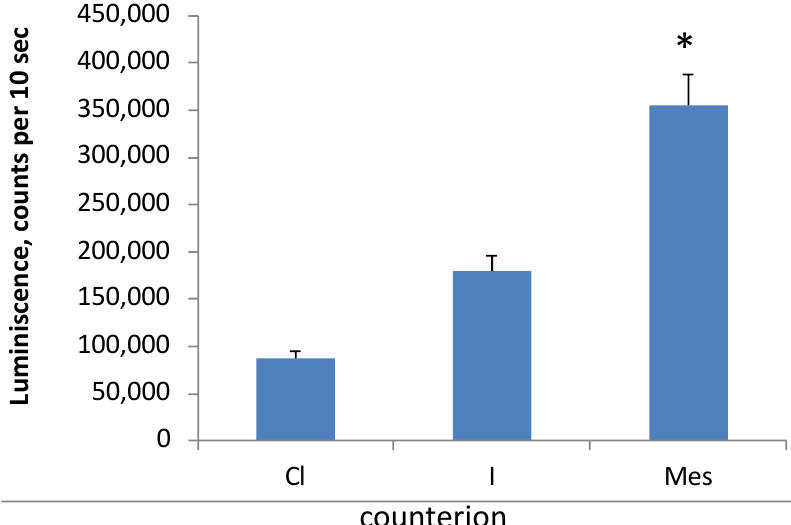
Figure 6. Transfection efficiency of HEK 293T cells with mRNA–LNP (sample S1) lipoplexes depending on various counterions of DOTAP: chloride (Cl), iodide (I) or mesylate (Mes). *, A statistically significant difference from samples with Cl and I counterions, p ≤ 0.05. Incubation time was 24 h, n = 3.